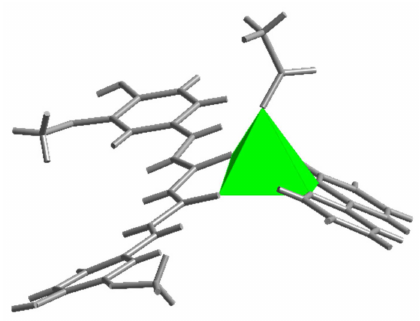
Figure 3. The square pyramidal environment of zinc ion in [Zn(CH 3 COO)(cur)(bpy)]( 1 ).